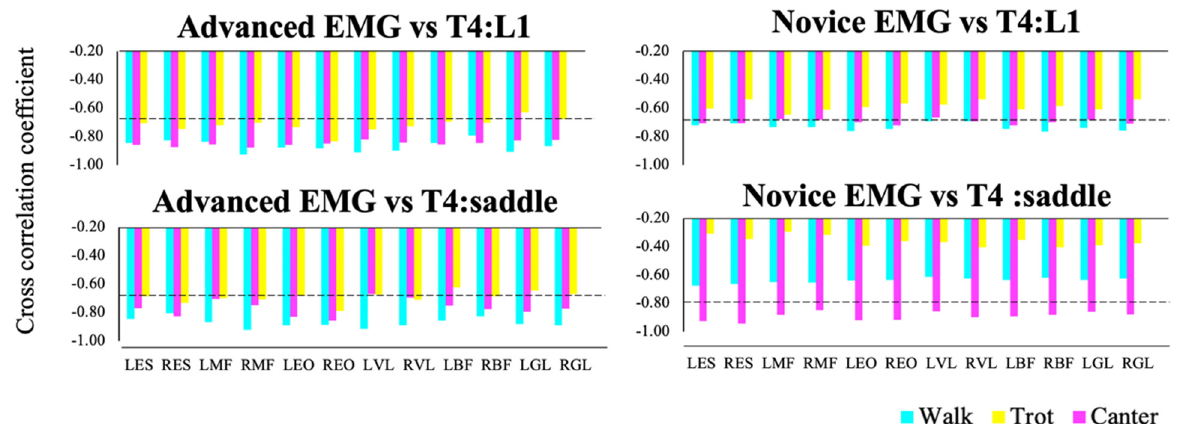
Figure 3. Peak sEMG and shock attenuation cross-correlation coefficients of advanced and novice riders. Dotted line indicates high correlation threshold.